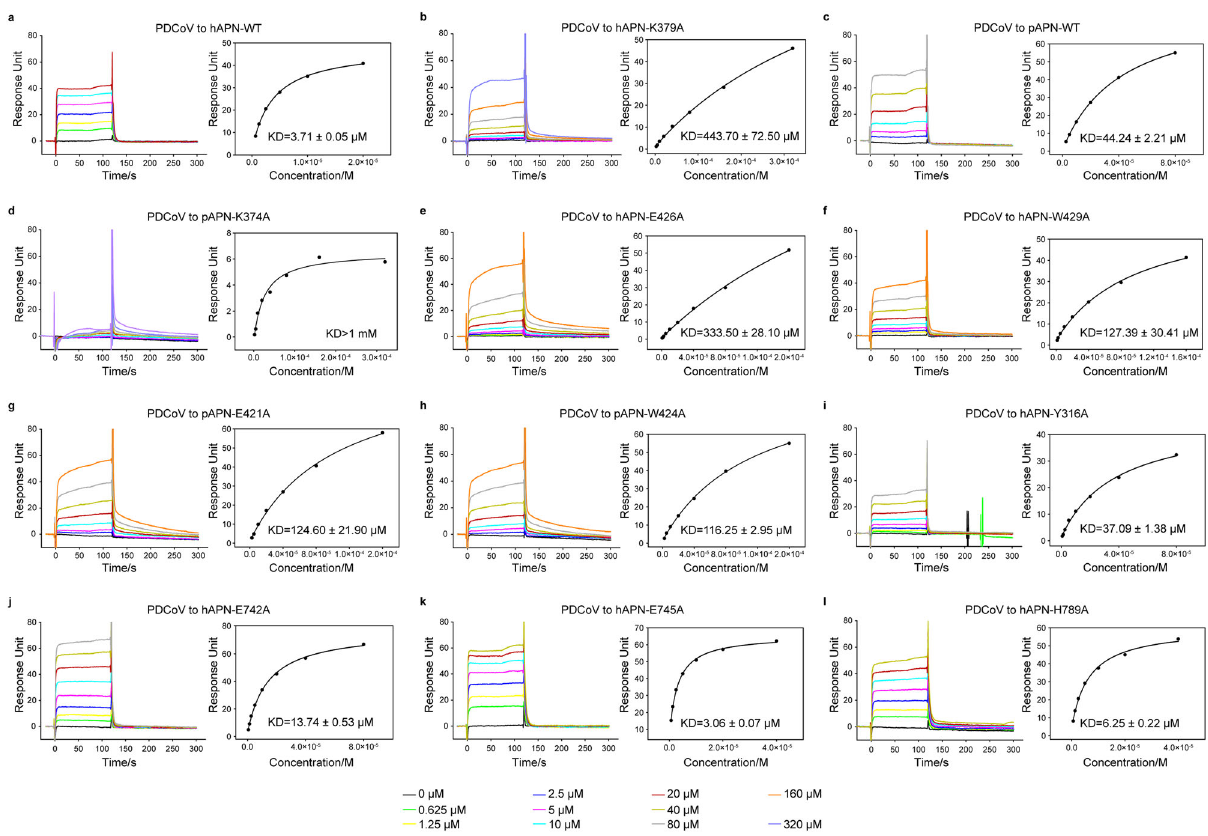
Fig. 4 Binding of PDCoV RBD to wildtype (WT) or mutant hAPN/pAPN measured by SPR. a Binding of PDCoV RBD to hAPN WT. b , e , f , i – l Binding of PDCoV RBD to different hAPN mutants. c Binding of PDCoV RBD to pAPN WT. d , g , h Binding of PDCoV RBD to different pAPN mutants. The equilibrium binding curve and derived dissociation constant is shown for each pair of interacting proteins. KD values are expressed as the mean ± SD, n = 2. SPR sensorgrams are provided as a Source Data fi